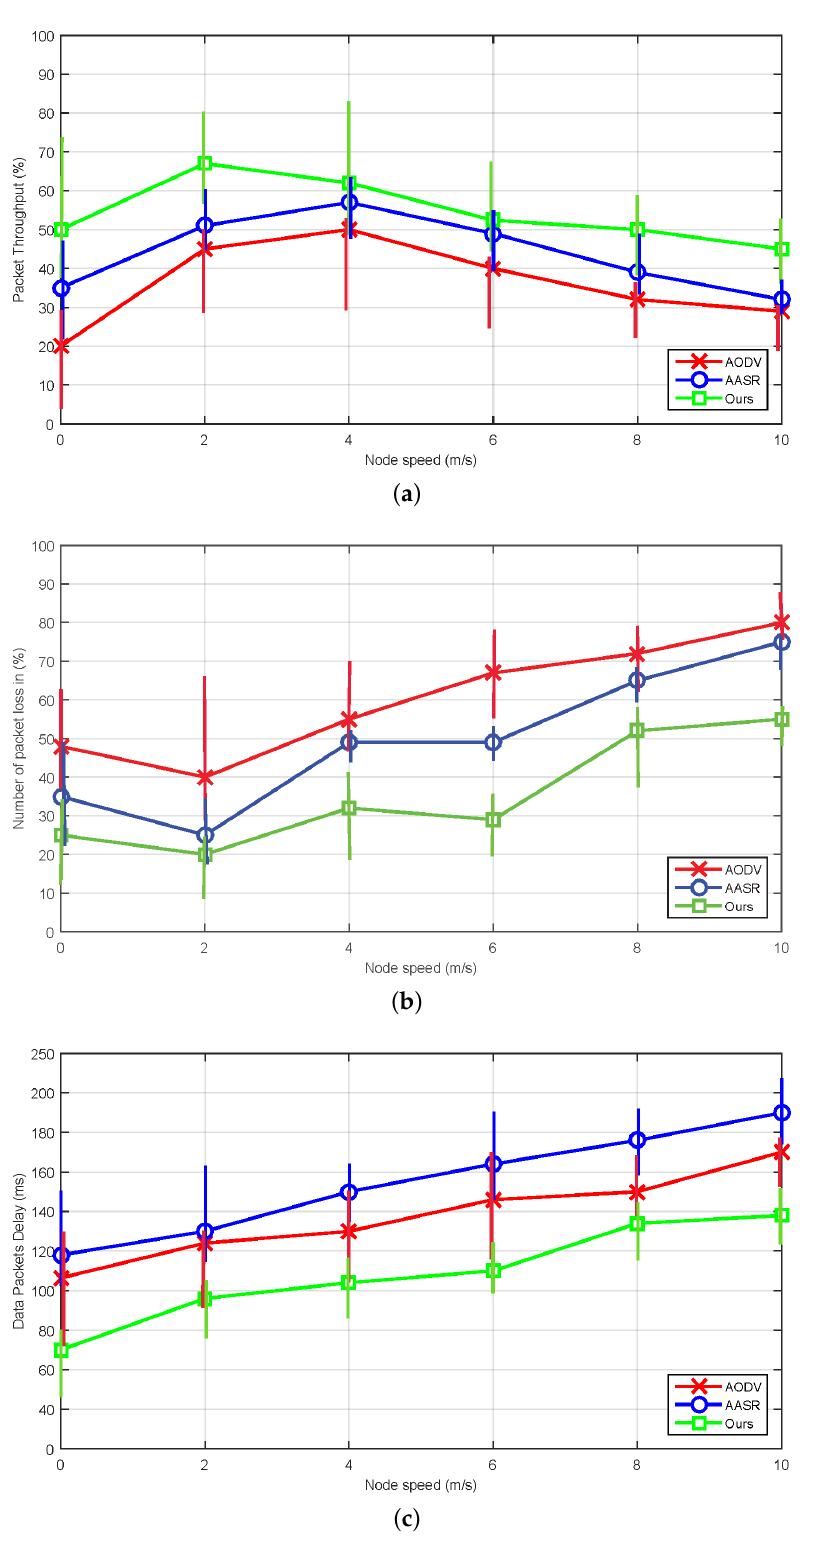
Figure 8. Performance comparison under different mobility setting: ( a ) Packet throughput. ( b ) Packet loss ratio. ( c ) End-to-end